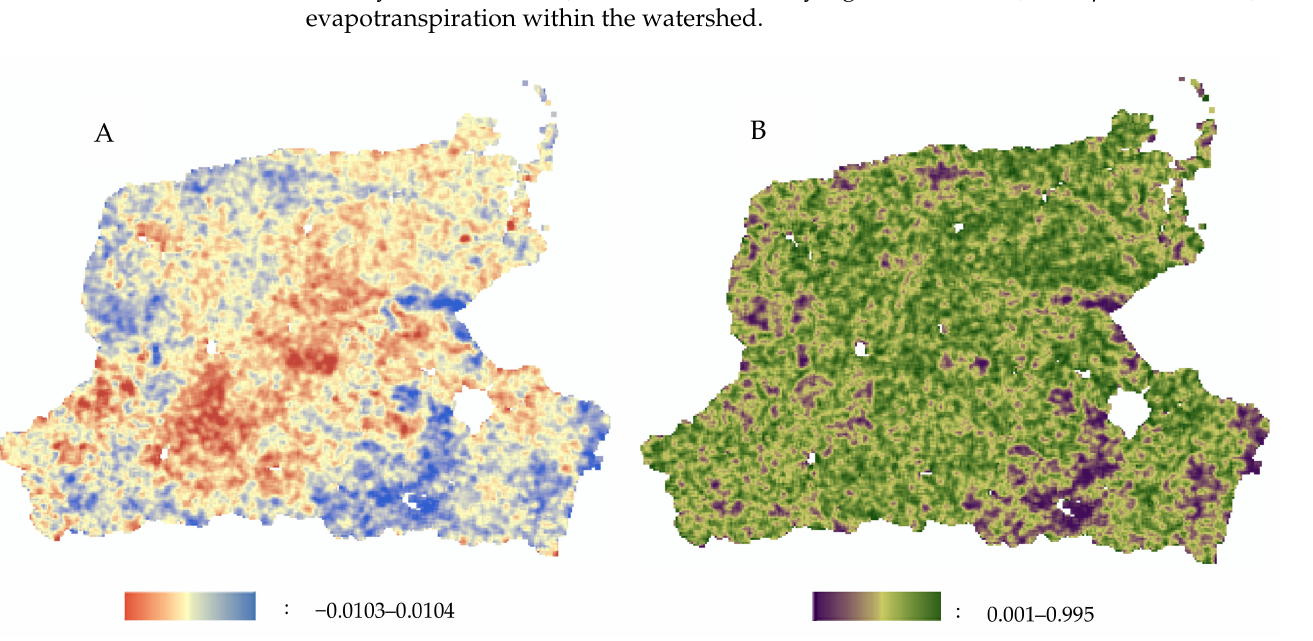
Figure 8. The Sen’s slope ( A ) and p -values ( B ) of the Mann–Kendall test performed on long-term annual PET 2001–2021 in the Brantas